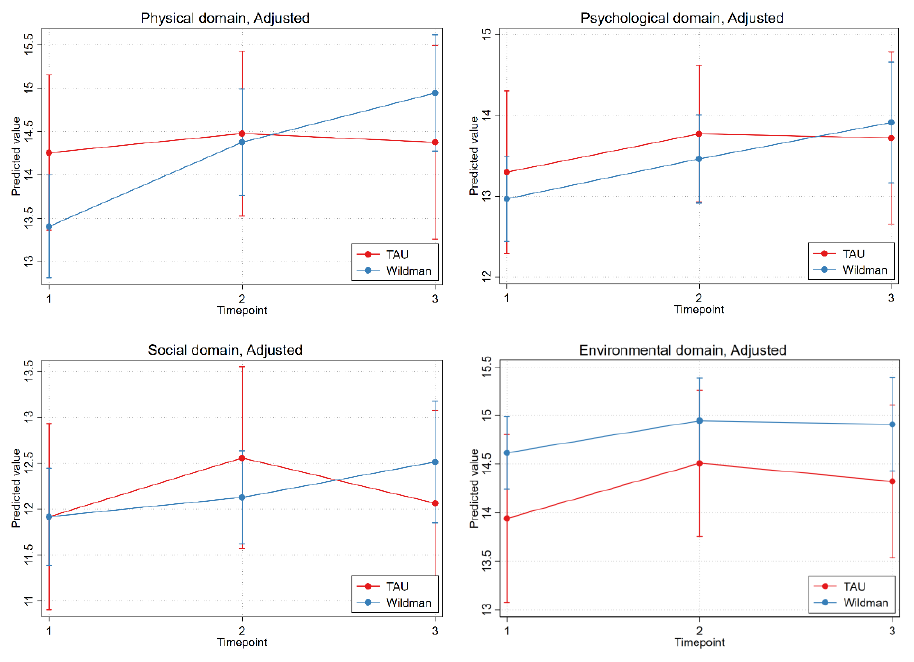
Figure 3. Adjusted analysis of the differences in the development of the intervention group and control group on the four WHOQOL-BREF domains.